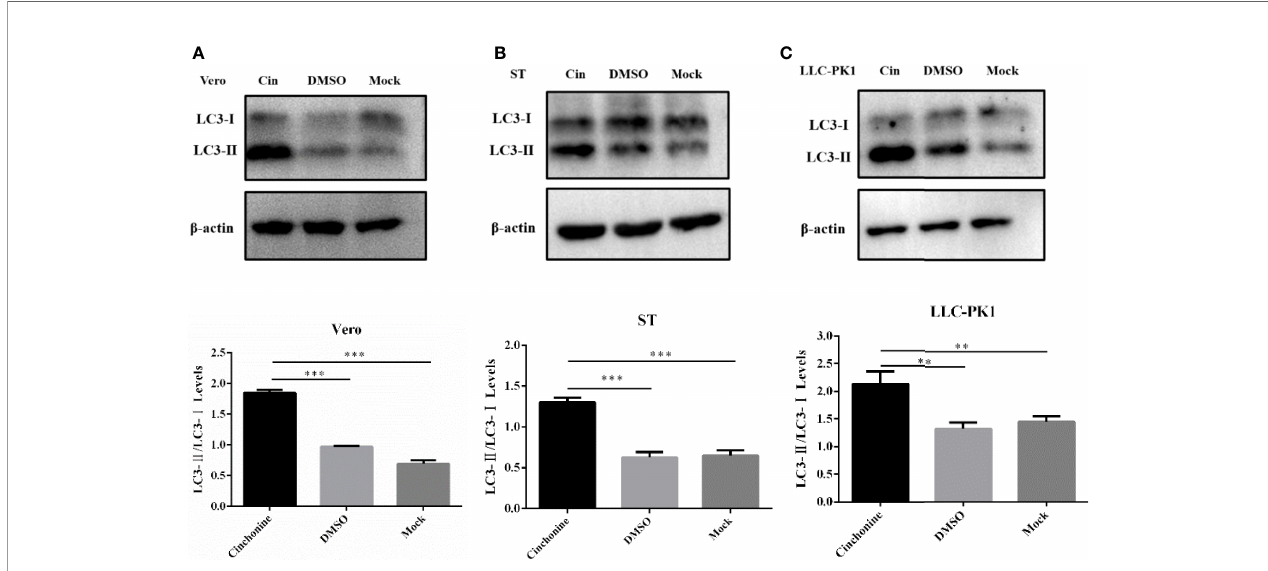
FIGURE 4 | Expression of autophagy marker protein LC3 in cinchonine-treated cells. (A – C) Vero CCL81 cells, ST cells and LLC-PK1 cells were treated with 100 m M cinchonine for 24 h respectively, and the LC3 conversion was examined by Western Blot. The LC3-II/LC3-I levels were calculated by Image-Pro Plus 6.0 software. The above data has been expressed as the mean ± SD of at least three independent experiments. p < 0.05; ** p < 0.01; *** p < 0.001; **** p ≤ 0.0001; ns, not signi fi